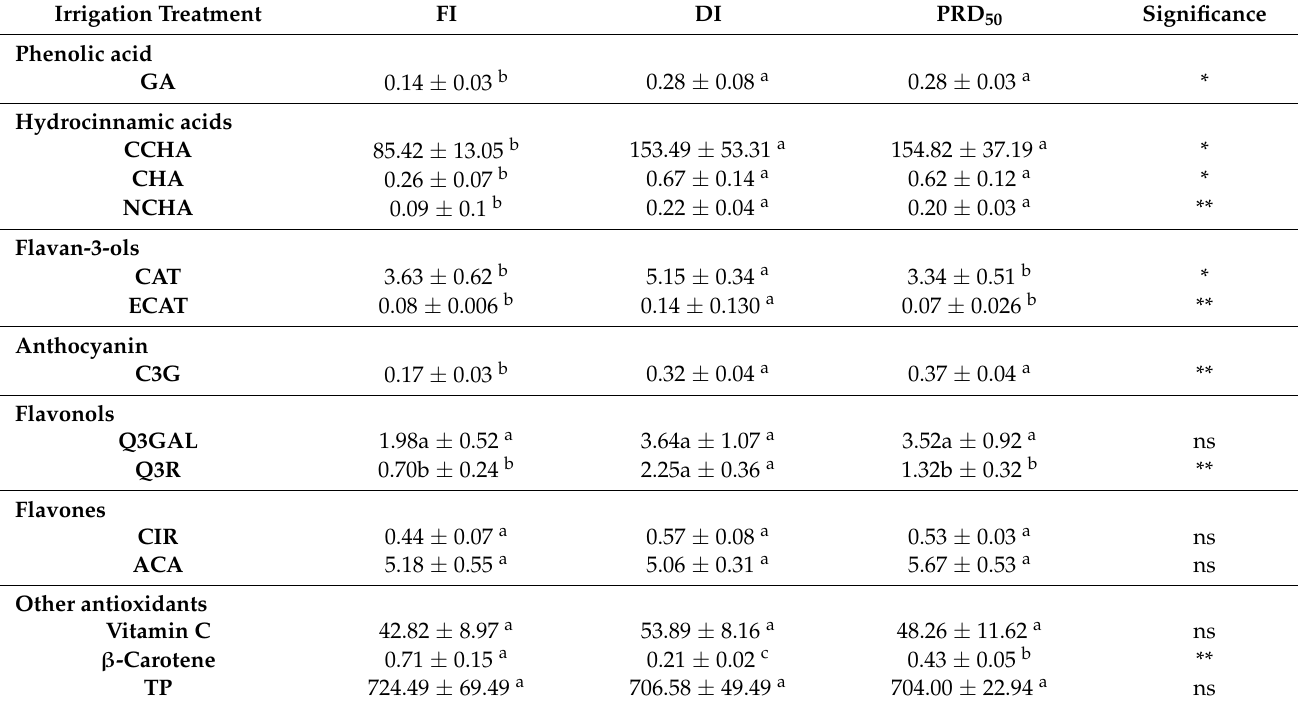
Table 3. Total phenol content (mg GAE 100 g − 1 DM) and individual phenolic